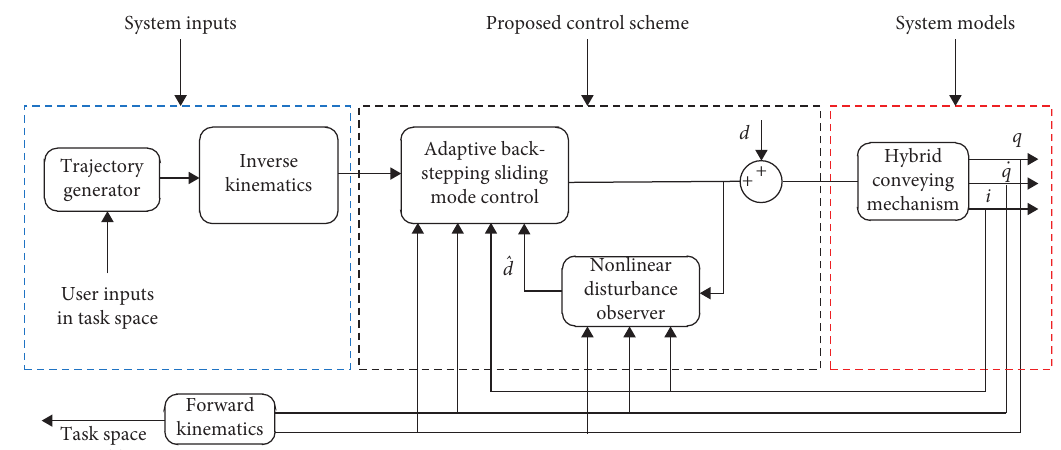
Figure 2: Schematic diagram of ABSMC +NDO for the hybrid conveying